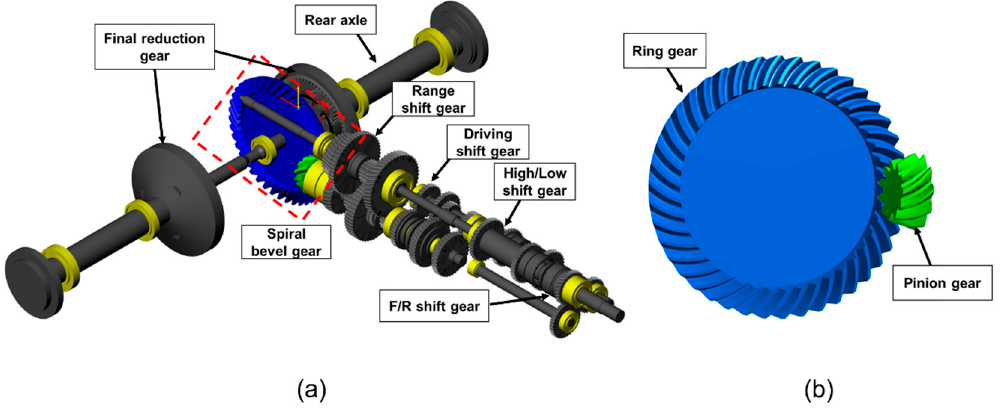
Figure 3. Simulation model of the tractor used in this study: ( a ) transmission and ( b ) spiral bevel gear.